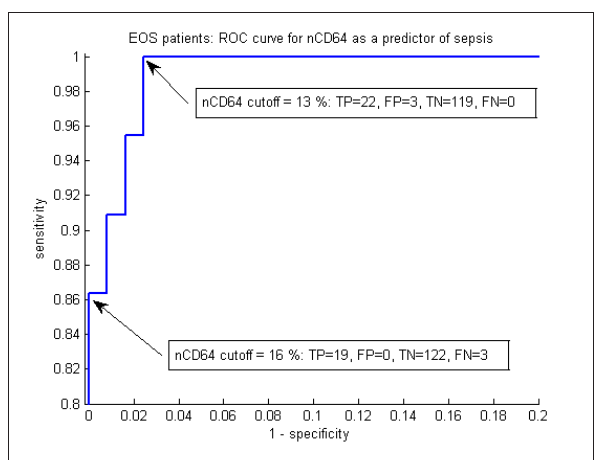
Fig. 2. A portion of the ROC curve: comparison of sensitivity and specificity for various nCD64 cutoffs; true positive (TP), false positive (FP), true negative (TN) and false negative (FN)